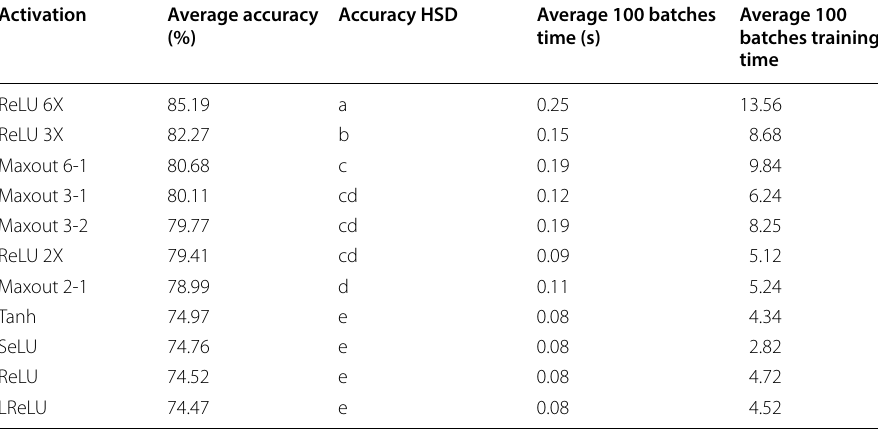
Table 8 Activation HSD test on image